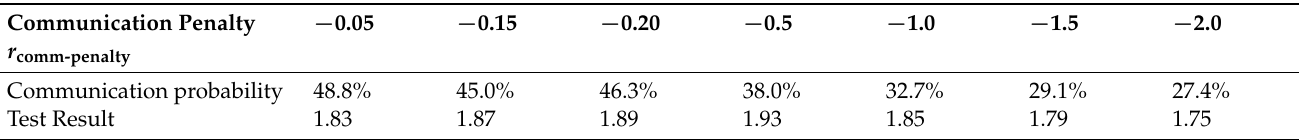
Table 3. Communication probability and test result for different communication cost in Starcraft.